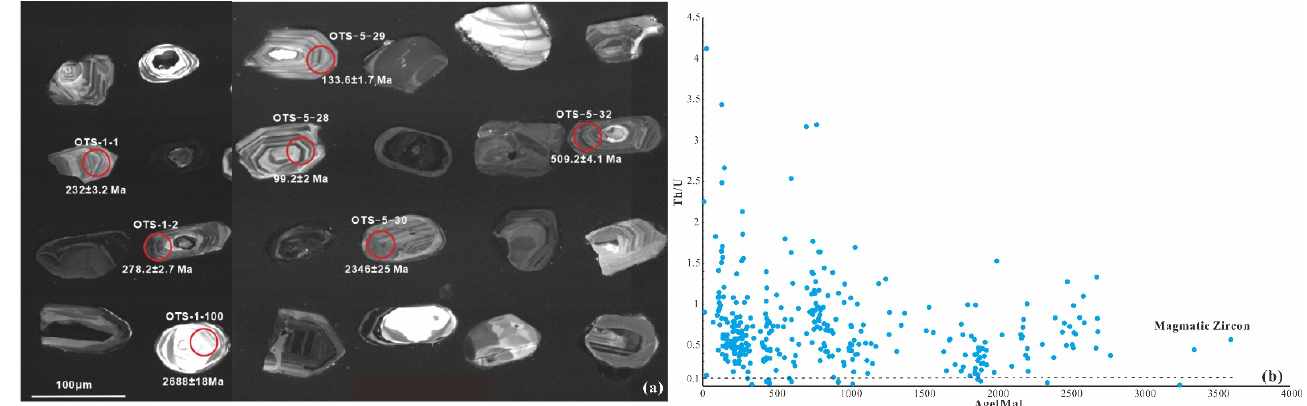
Figure 3. Cathodoluminescence images and U-Th ratios of detrital zircon grains from sediments in H4-S2. ( a ) Cathodoluminescence images; ( b ) U-Th ratios. Red circles indicate the dating points.